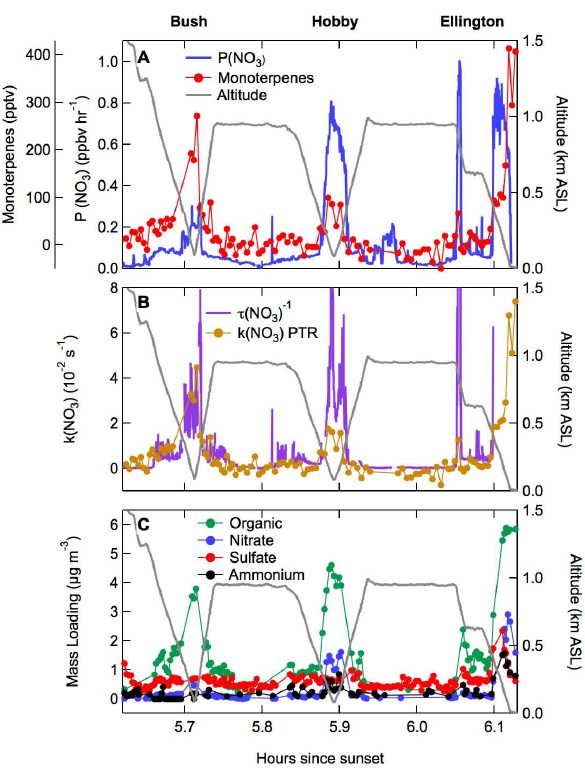
Fig. 6. Time series (plotted as hours since sunset) from five ver- tical profiles between midnight and 01:00 local time on 11 Octo- ber showing (A) nitrate radical production rate, P (NO 3 ) (left axis), monoterpene mixing ratio (far left axis) and aircraft altitude (right axis); (B) inverse NO 3 lifetime, τ (NO 3 ) − 1 , and first-order NO 3 loss rate coefficient, k (NO 3 ) from PTRMS measurements of biogenic VOCs (see text), plotted together against the left axis; (C) mass loading of aerosol organic, nitrate, sulfate and ammonium from the AMS. Aircraft altitude is plotted against the right axis for reference in (B) and (C)